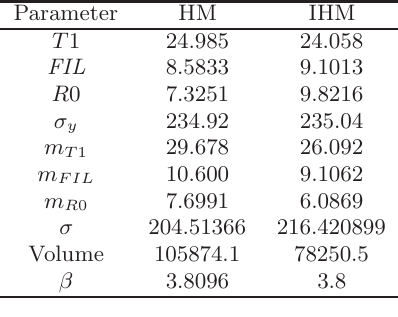
Table 6. Result of HM and